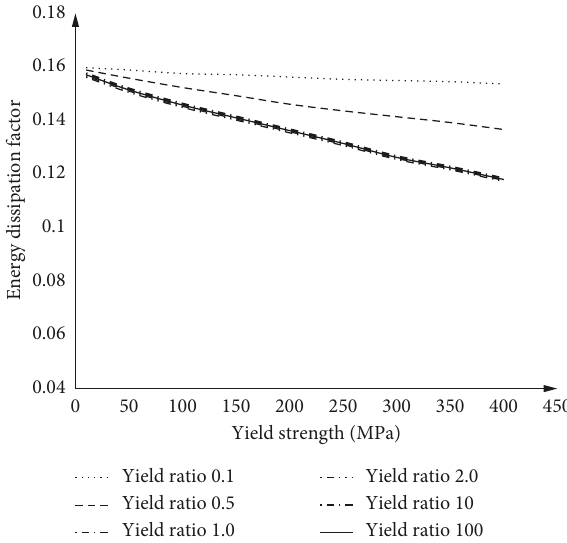
Figure 14: Curve of the energy dissipation factor under different yield strengths.